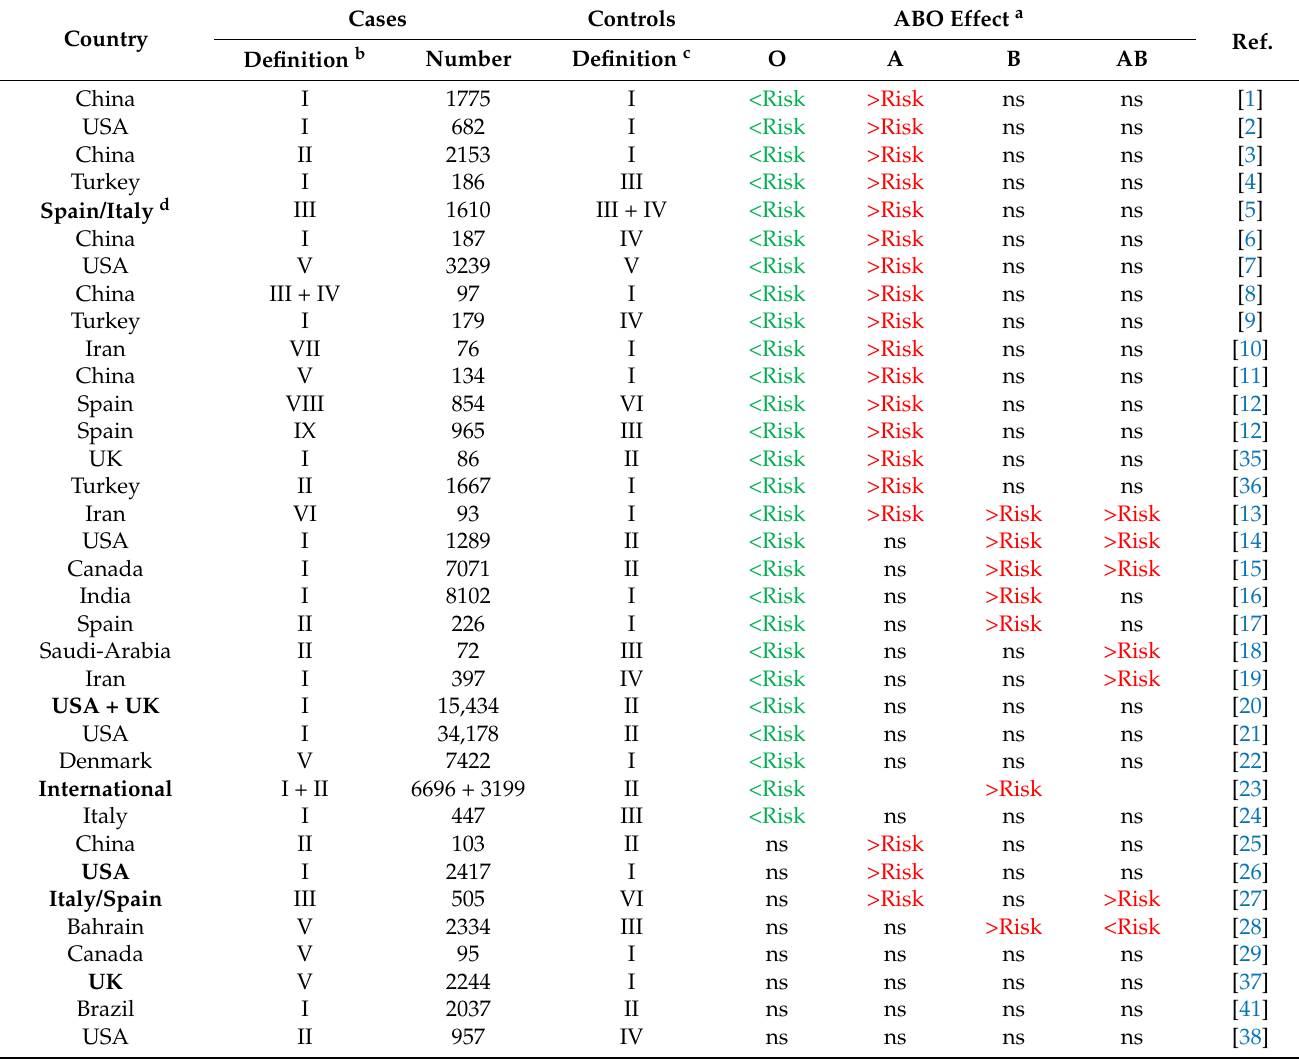
Table 1. Case–control studies reporting data on ABO blood groups and